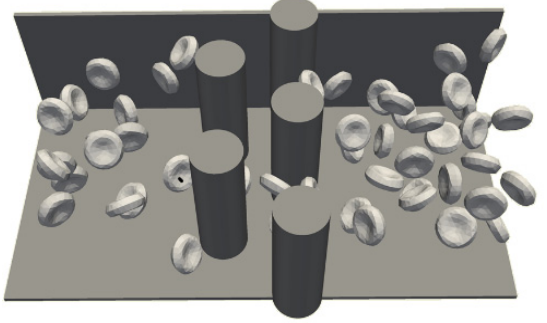
Fig. 11. Geometry C with 50 randomly distributed red blood